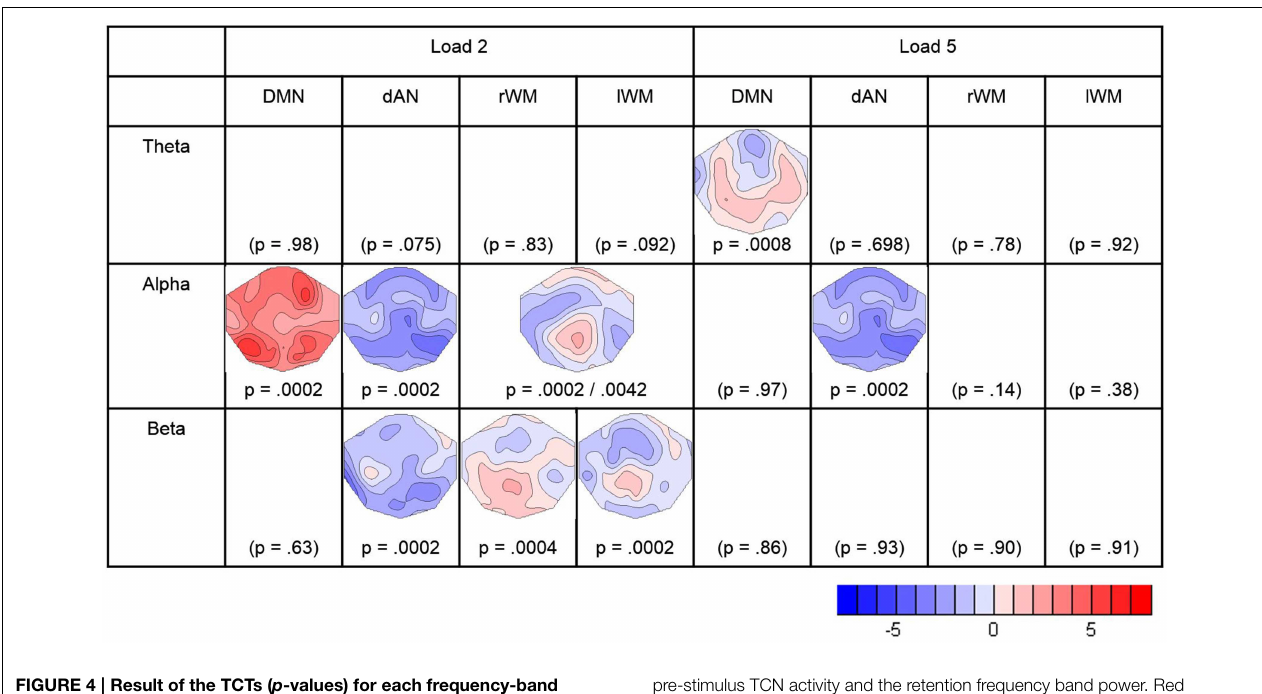
pre-stimulus TCN activity and the retention frequency band power. Red indicates positive t -values representing positive correlations. The figure contains the results surviving the adjustment for a FDR of